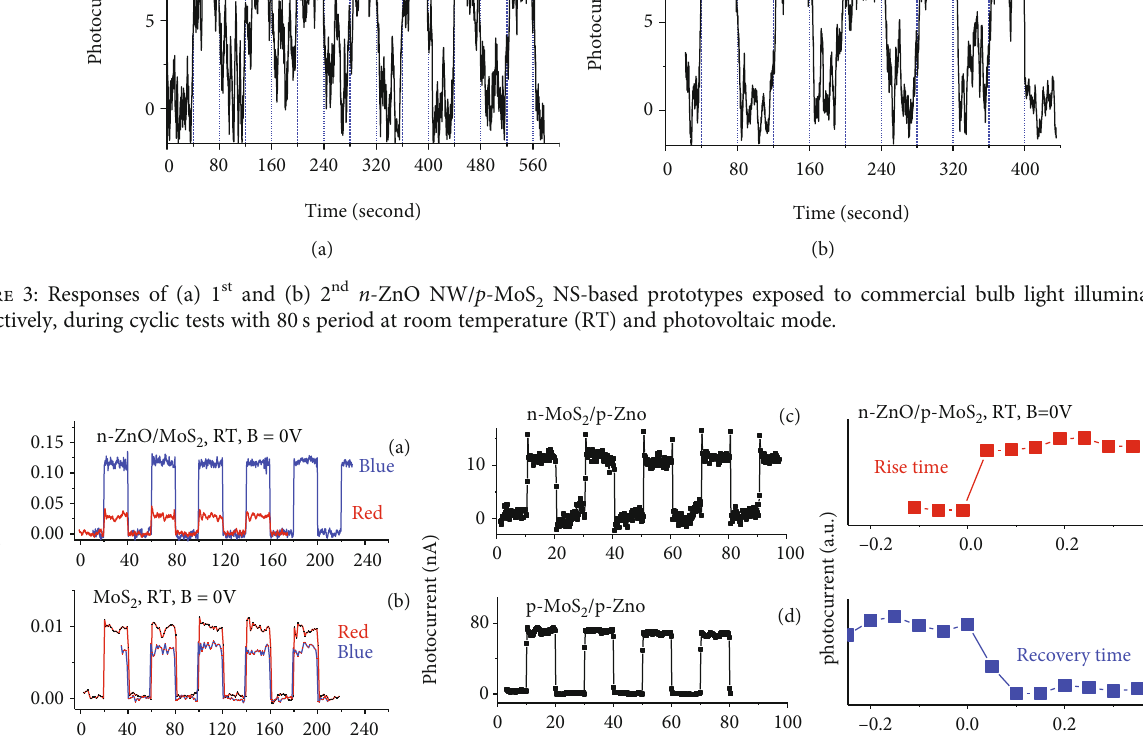
NS-based, (b) n -MoS NS-based, (c) n -MoS NS/p-ZnO NP-based, and (d) p -MoS 2 2 2